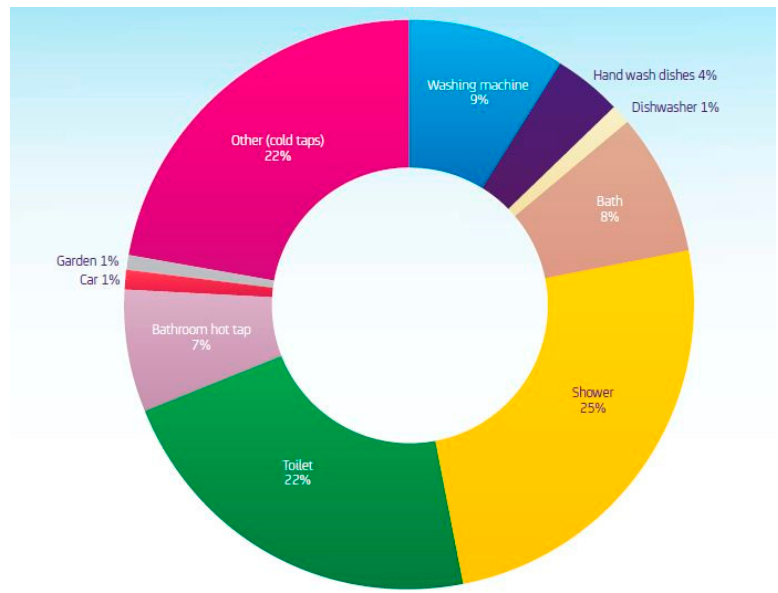
Figure 7. Distribution of water usage in a conventional household [13].